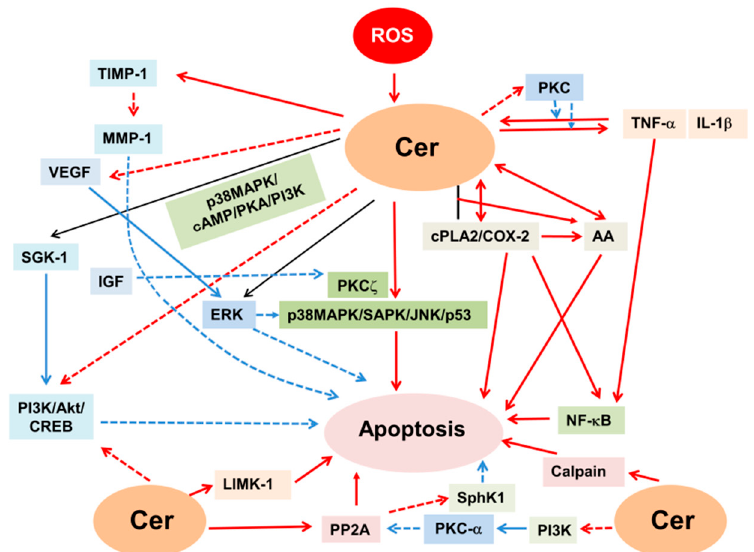
Figure 5. Ceramide-induced apoptotic signaling pathways in oxidant-induced kidney injury. ROS- induced Cer activates proinflammatory cytokines (TNF- α , IL-1 β ), ERK, p38MAPK, SAPK/JNK through PKC ζ , p53, Ca 2+ -dependent calpain, NF-kB through cPLA2/COX-2, and TIMP-1, which decreases MMP-1 that suppresses apoptosis, leading to apoptosis. All these factors function as apoptotic except for anti-apoptotic ERK, which is antagonistic to p38MAPK activation, and MMP-I that functions anti-apoptotic. Cer inhibits VEGF. VEGF and IGF-I suppress Cer-induced apoptosis by activating ERK and by inhibiting PKC ζ which suppresses Cer-activated SAPK/JNK, respectively. TNF- α -induced Cer production activates PLA2/COX-2, leading to apoptosis. Cer-induced PLA2 activation cleaves AA, and COX-2 is converted into AA, which promotes apoptosis. The binding of Cer to cPLA2 increases AA release, and both cPLA2 and AA increase Cer production, resulting in apoptosis. Cer activates TNF- α -induced NF- κ B, cPLA2, AA, LIMK-1 that regulates cytoskeletal organization and IL-1 β via inhibition of PKC, leading to apoptosis. Cer inhibits PI3K/Akt/CREB, which functions as anti-apoptotic. Cer suppresses PKC- α that inhibits PP2A activity by decreasing PI3K, which subsequently activates PP2A and results in apoptosis. Cer-induced activation of PP2A inhibits SphK1 activity that functions as anti-apoptotic, leading to apoptosis. Cer increases SGK-1 without increasing its phosphorylation via p38MAPK/cAMP/PKA/PI3K and decreases Akt activity, while overexpression of SGK-1 prevents apoptosis by activating PI3K/Ak. Abbreviations; AA; arachidonic acid, COX-2; cyclooxygenase-2, CREB; cyclic adenosine monophosphate response element-binding protein, ERK; extracellular signal-regulated kinase, IL; interleukin, JNK; Jun N-terminal protein kinase, LIMK-1; LIM kinase-1, MAPK; mitogen-activated protein kinase, MMP-1; matrix metalloproteinase-1, NF- κ B; nuclear factor- κ B, PI3K; phosphatidylinositol 3-kinase, PKC; protein kinase C, cPLA2; cytosolic phospholipase A2, PP2A; protein phosphatase 2A, SAPK; stress-activated protein kinase, SGK-1; serum- and glucocorticoid-inducible protein kinase-1, SphK1; sphingosine kinase 1, STAT: signal transducer and activator of transcription, TIMP-1; tissue inhibitor of matrix metalloproteinase-1, TNF- α ; tumor necrosis factor- α , VEGF; vascular endothelial growth factor. Dashed arrow indicates that Cer increases the expression but no phosphorylation of SGK-1. Red arrow; apoptotic, blue arrow; anti-apoptotic. → ; stimulation, dashed arrow, inhibition. ROS-induced ceramide suppressed vascular endothelial growth factor (VEGF) expres- sion, leading to apoptosis [26,75], whereas aSMase-knockout attenuated these events [75]. VEGF prevented ceramide-induced apoptosis by activating ERK [171]. In addition, ce- ramide activated ERK in ECs [172], whereas ERK by itself functions as anti-apoptotic [172] or antagonistic to p38MAPK activation [109], ameliorating ceramide-induced apopto- sis [173]. Thus, ERK functions as anti-apoptotic in oxidant-induced kidney injury. In contrast, ROS-induced ceramide activated p38MAPK, which resulted in the apoptosis of RTCs [108] and ECs [69]. OxLDL mediated by ROS produced ceramide, which in